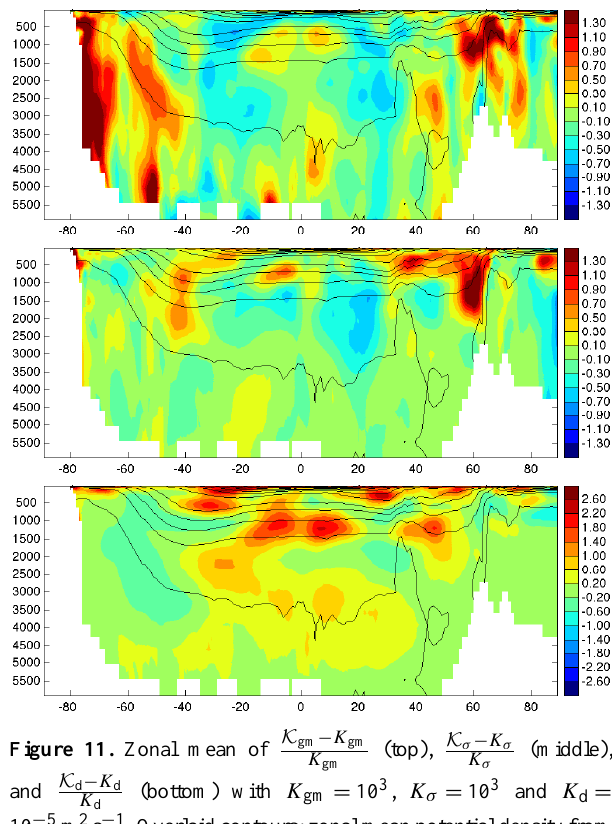
K gm − K gm Figure 11. Zonal mean of (top), K σ − K σ (middle), K gm K σ − K d and K d (bottom) with K gm = 10 3 , K σ = 10 3 and K d = K d 10 − 5 m 2 s − 1 . Overlaid contours: zonal mean potential density from the OCCA